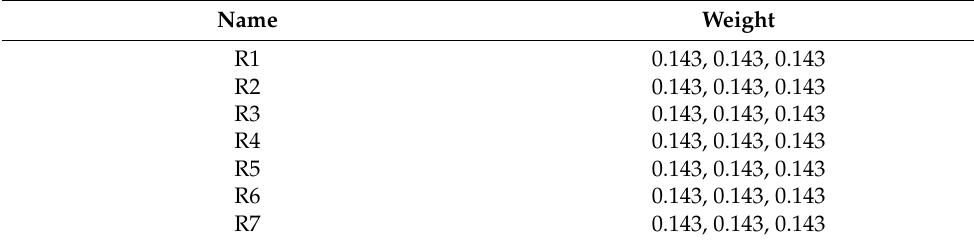
Table 2. Features of Different